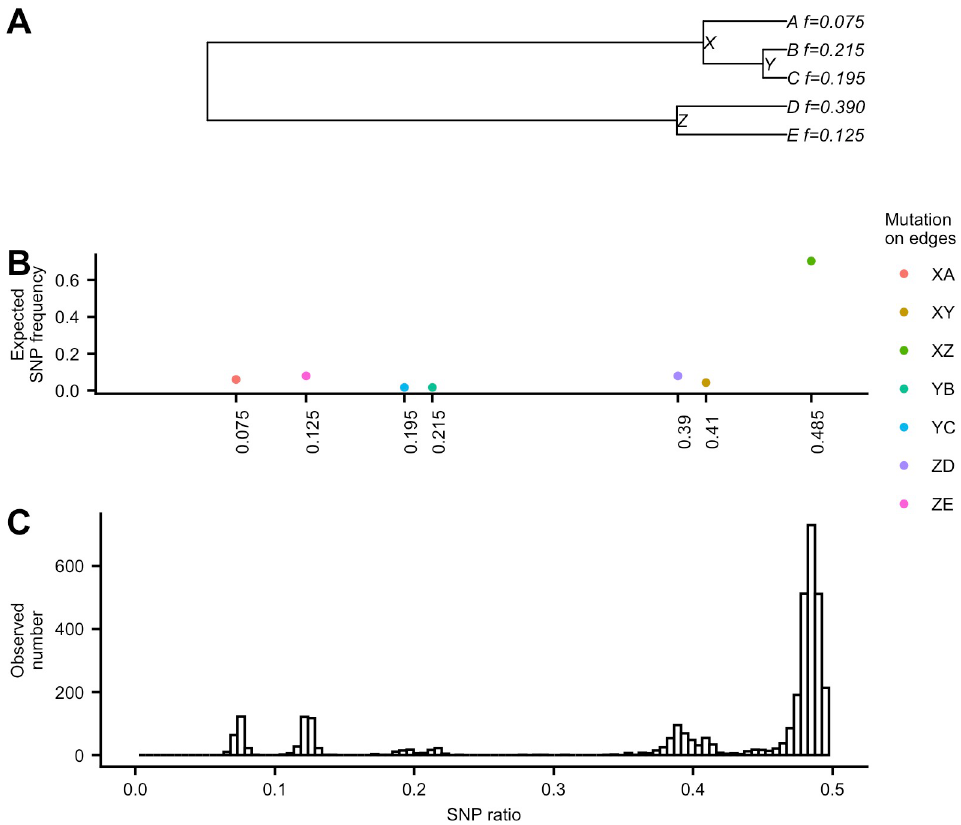
Fig 1. SNP frequencies vs SNP ratios. (A) An example of a 5-tip tree with expected tip relative abundances (i.e. haplotype relative abundances). (B) The expected SNP frequencies against the expected SNP ratio of the occurrences for the mutations on different edges of the tree. (C) The observed distribution of SNP ratios from the short read sequences generated from five simulated genomic sequences with expected relative abundances based on the tree in (A). To obtain observed frequencies and relative abundances, paired-end error-free reads of length 150bp with total coverage of 15,000x were simulated by ART [9] from five 50k-long haplotype sequences generated by INDELible [10] with JC model [11].